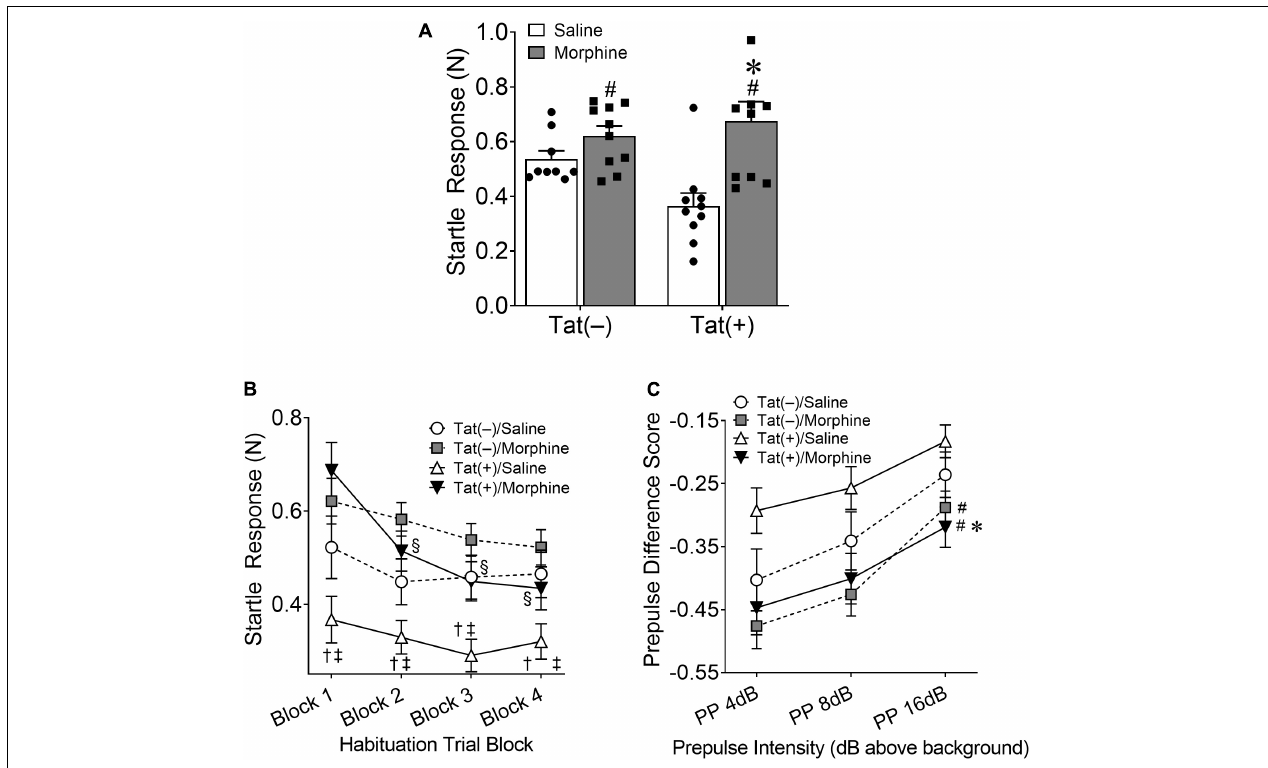
FIGURE 2 | HIV-1 Tat decreases, whereas morphine increases the acoustic startle response. Tat(+) and Tat(–) mice were given DOX chow for 8 weeks and received ramping morphine (or saline) during the last 2 weeks of exposure. In the acoustic startle response test, repeated morphine increased the startle response (A) . In contrast, Tat decreased the startle response in saline-treated mice (A) . During habituation testing Tat(+)/saline (trial blocks 3 and 4) and morphine (across all trial blocks) mice exhibited significantly higher startle responses compared to Tat(–)/saline mice (B) . However, only Tat(+)/morphine mice exhibited habituation to the startle response (B) . Further, in combination, Tat and morphine decreased the prepulse inhibition (PPI) to the acoustic startle response (C) . Data are presented as the mean ± the SEM; n = 9–10 mice per group; ∗ p < 0.05, pairwise comparison difference from Tat(+)/saline; † p < 0.05, pairwise comparison difference from Tat(–)/morphine; ‡ p < 0.05, pairwise comparison difference from Tat(+)/morphine; § p < 0.05, Tat(+)/morphine significantly decreased from block 1; # p < 0.05, main effect of morphine. N, newton; dB, decibel.